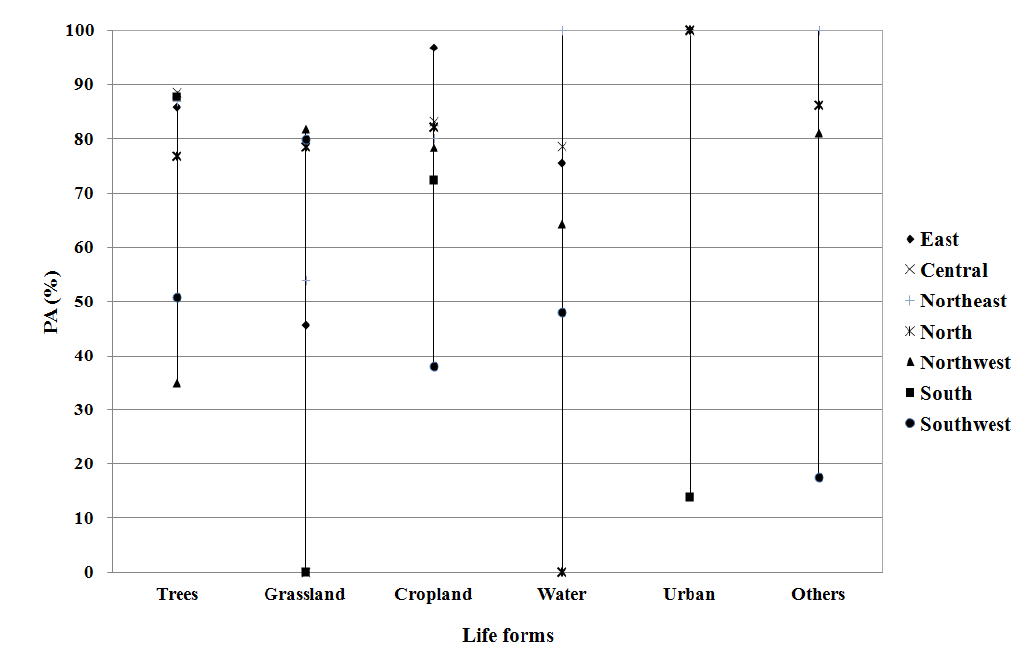
Figure 9. Producer’s accuracy for GLCD-2005 over seven geographical regions of